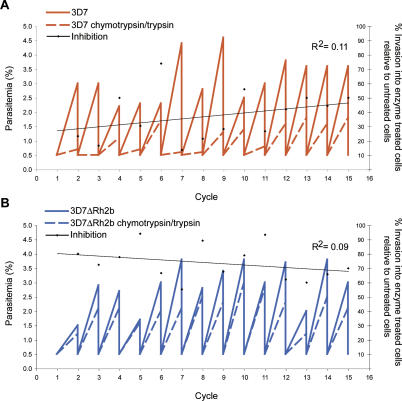
Long-Term Selection of (A) 3D7 and (B) 3D7ΔRh2b in Erythrocytes Pretreated with Chymotrypsin (1.5 mg/ml) and Trypsin (0.1 mg/ml) Shows No Significant Change in Receptor DependencyParasitemia was measured by microscopy; then cultures were diluted down to 0.5% parasitemia at 48-h intervals. Cultures were maintained for greater than 30 d. Secondary y-axis represents invasion into enzyme-treated erythrocytes as a percentage of invasion into untreated erythrocytes, with a regression line plotted across the values.